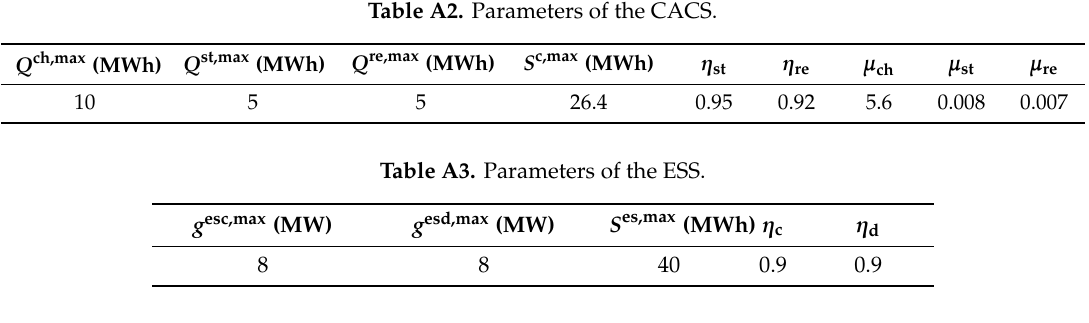
Table A4. Parameters of the public building.